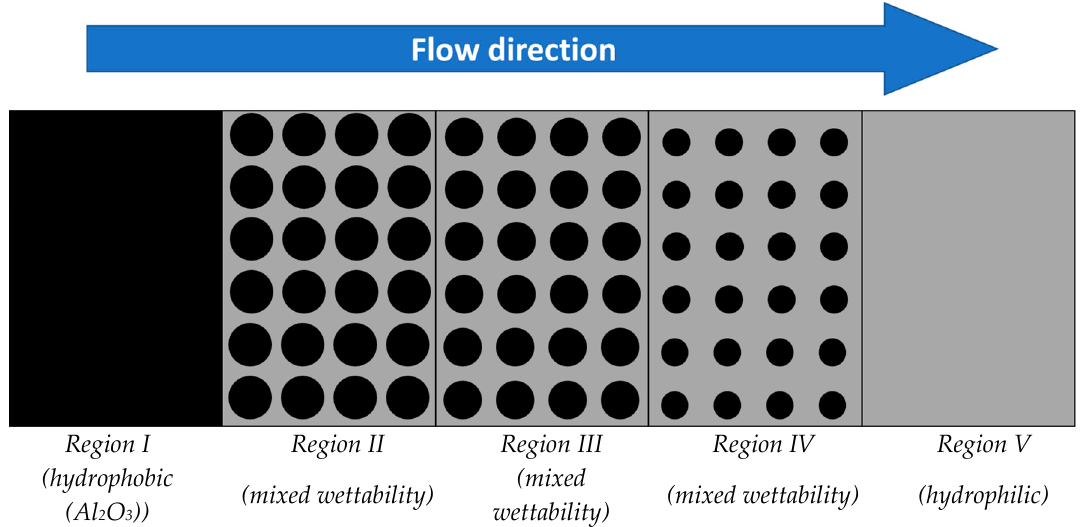
Figure 3. Schematic view of designed patterns.